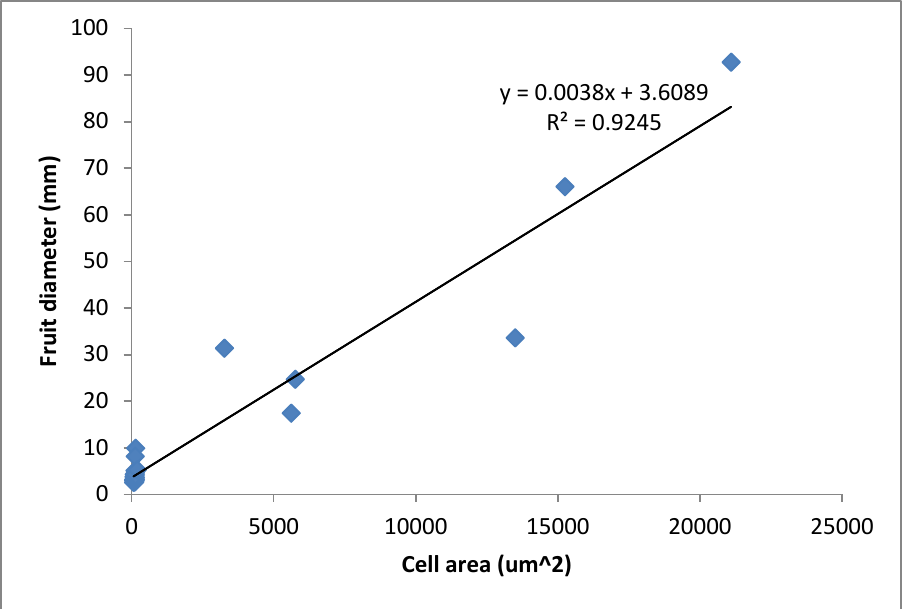
Figure 5. A graph depicting the relationship between fruit diameter and cell area for the three cultivars across 10 time points during harvest (Season 2). The best fit line indicates the linear correlation of the two variables ( p < 0.05, y = 0.0038x + 3.6089).